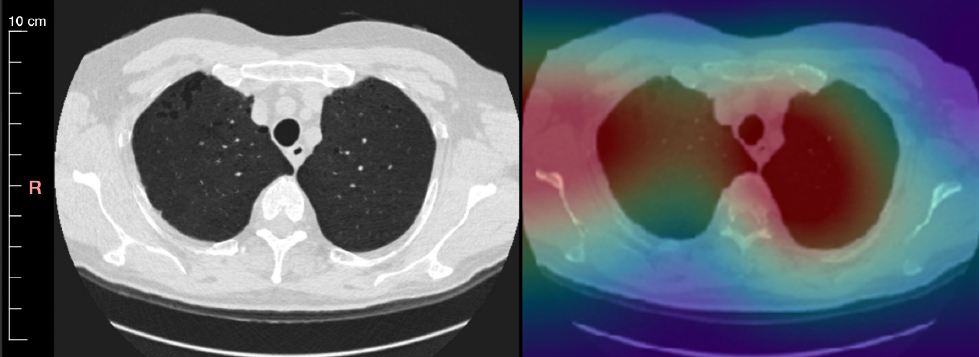
Figure 5. An inspiration chest CT slice of a 65-year-old male patient with mild emphysema is visualized in the lung window level 1500/ − 500 and reconstructed using medium smooth kernel. Left: CT scan with minimum intensity projection of slab thickness 5 mm Right: A saliency map generated by a convolution of an autoencoder that is overlayed onto the CT